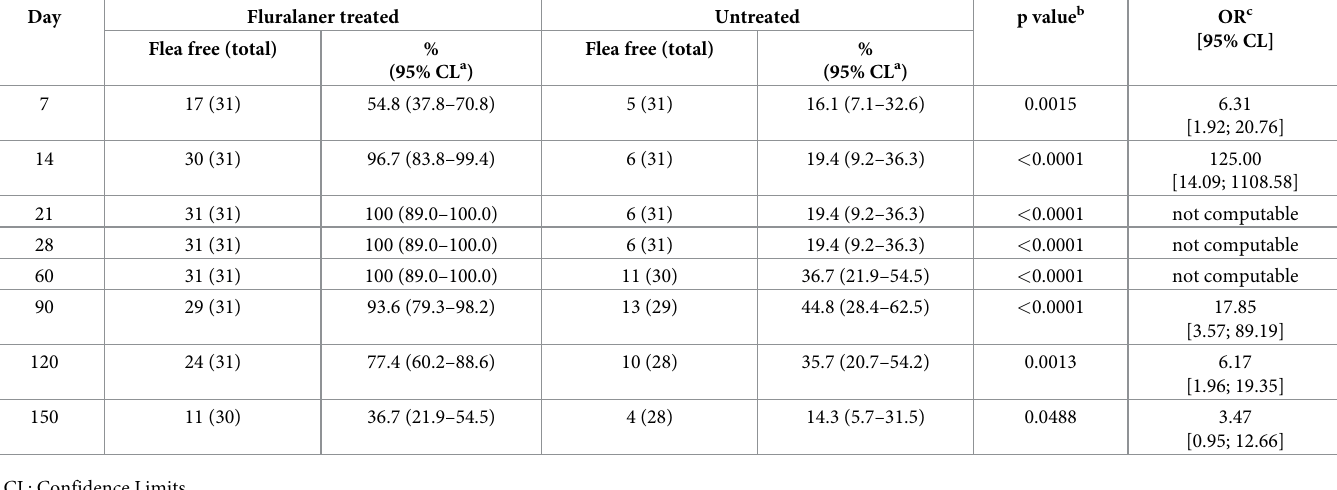
Table 3. Tunga penetrans free dogs at various time points following either a single oral dose of fluralaner or no treatment.